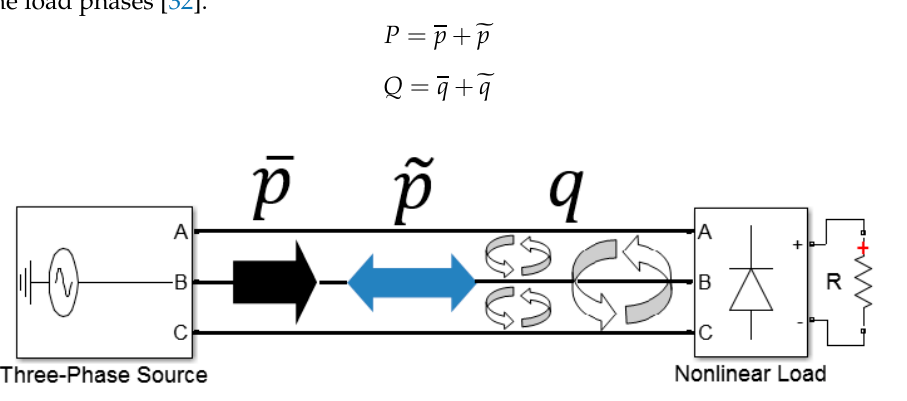
Figure 3. Power components of P-Q theory.